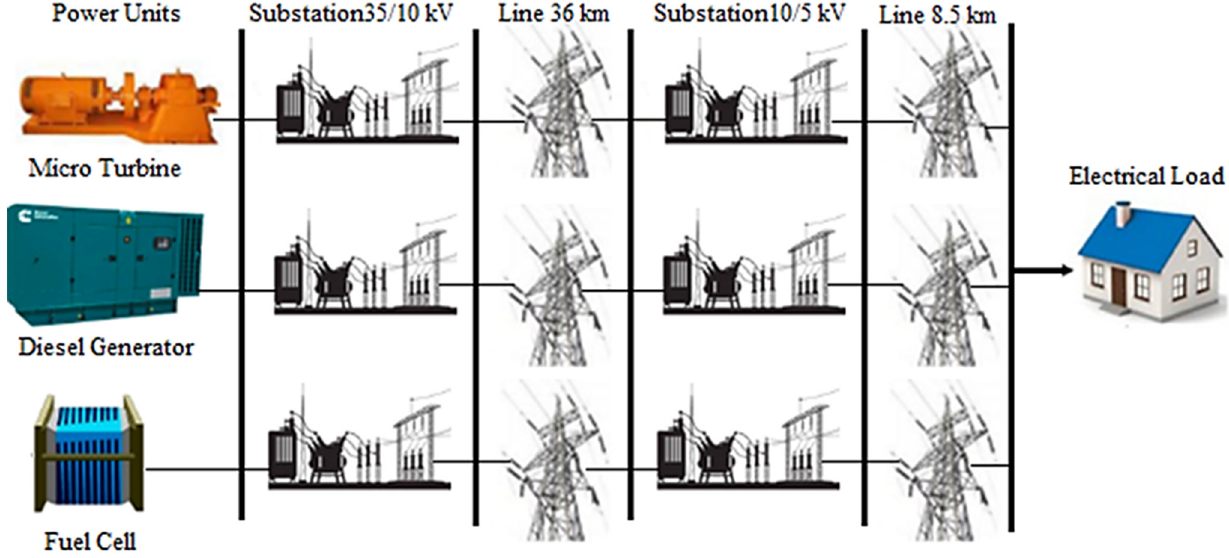
Figure 1. A series-parallel microgrid power system.